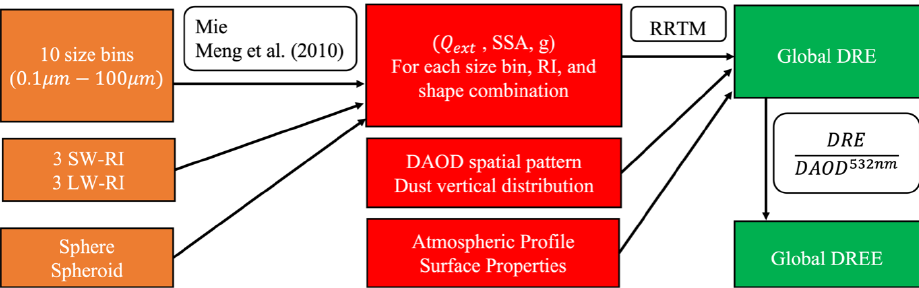
Figure 4. Schematic of the methodology used to derive size-resolved dust DREE dataset. Orange boxes denote dust models used to calculate dust scattering properties. Red boxes denote inputs for RRTM. Green boxes denote outputs from RRTM.